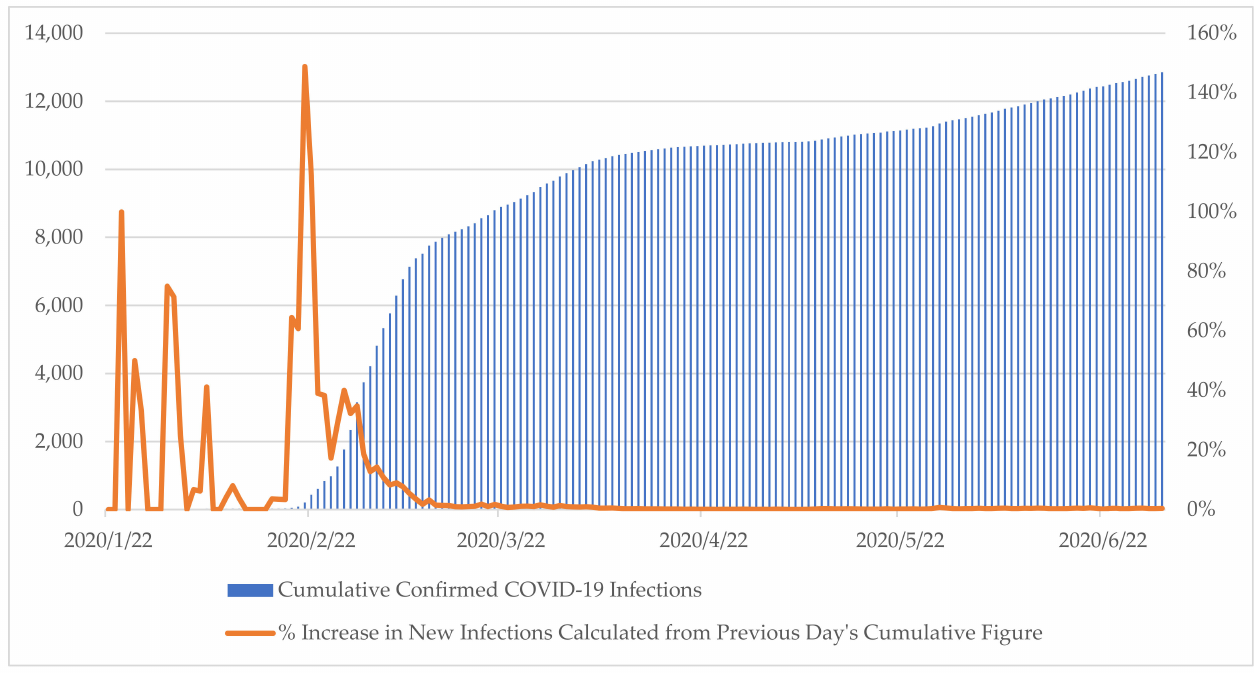
Figure 2. Korea COVID-19 Infection Trends from January 20, 2020, to July 1, 2020. Source: Korea Ministry of Health and Welfare. Coronavirus Disease-19. Available online: http://ncov.mohw.go.kr/en/ (accessed on 21 May